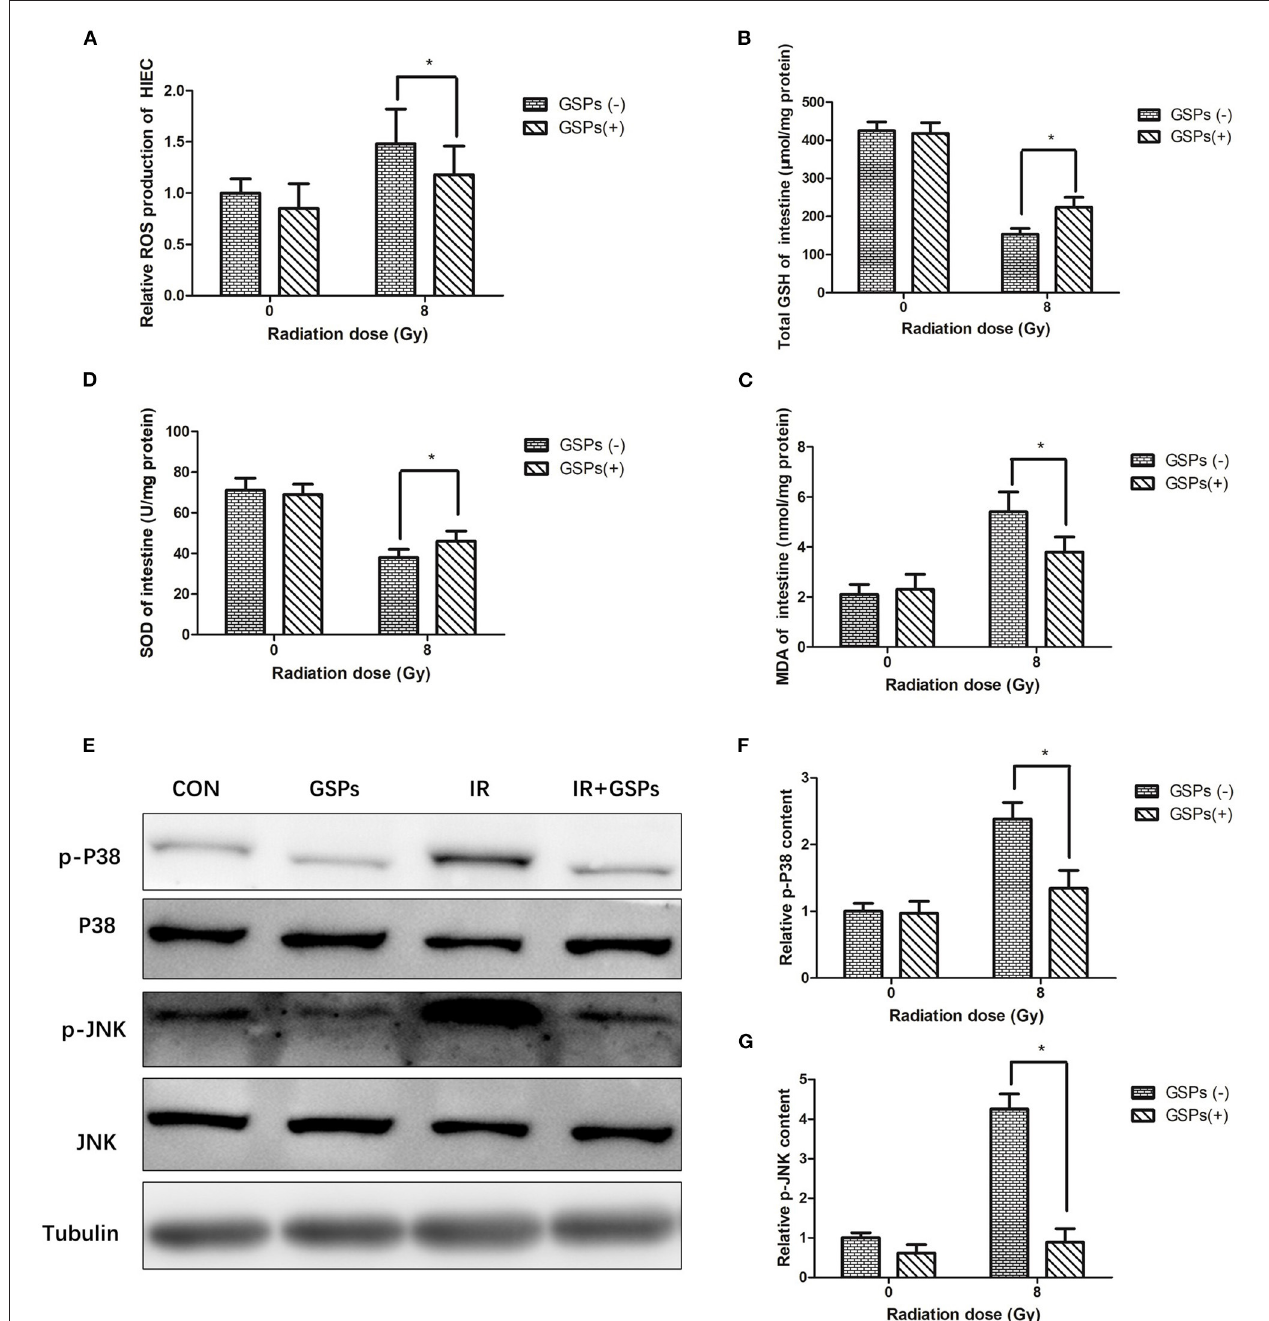
FIGURE 6 | Grape seed proanthocyanidins play a radioprotective effect in intestines through antioxidant effects and inhibition of MAPK signaling pathways. (A) GSPs eliminate the increased ROS of HIEC cells induced by IR. The content of GSH (B) and SOD (C) in the intestines decrease by IR, and the content of MDA (D) increases, while GSPs alleviate these changes. (E) GSPs inhibit the IR-induced activation of the MAPK signaling pathway, manifested as down-regulation of the expression of p-P38 and p-JNK. (F) Quantitative analysis of relative p-P38 content. (G) Quantitative analysis of relative p-JNK content. Data are presented as mean ± SD ( n = 3). * P <